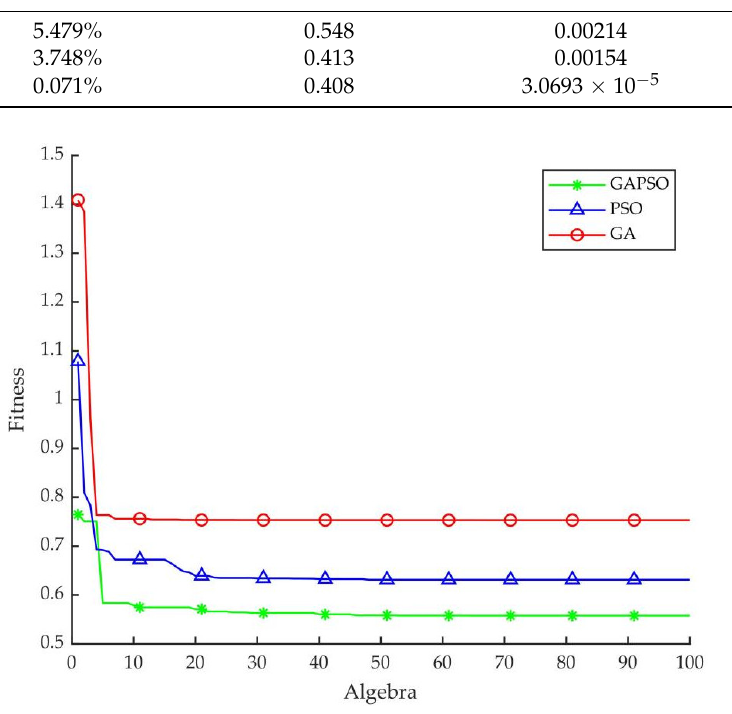
Figure 7. Comparison of control curves of fitness function.